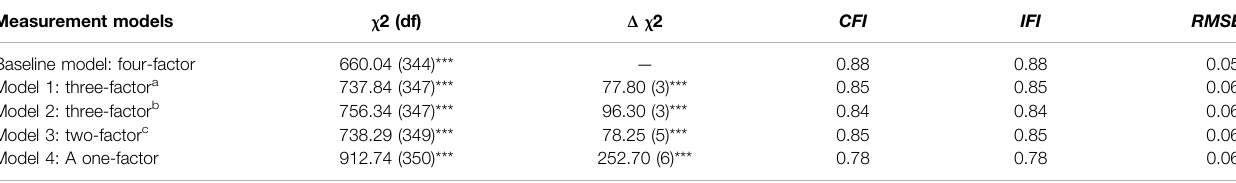
TABLE 2 | Results of con fi rmatory factor analysis of the measurement models. Measurement models